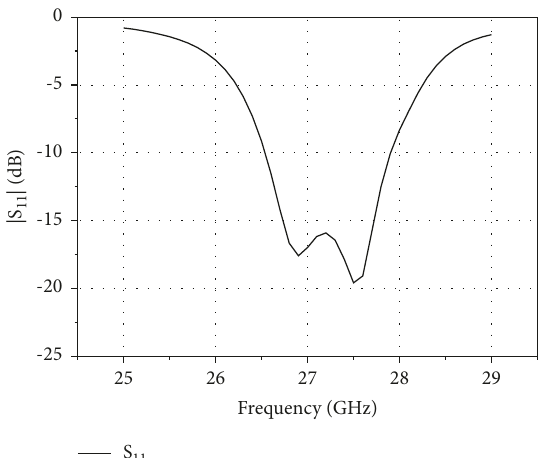
Figure 7: Principle of pattern multiplication.